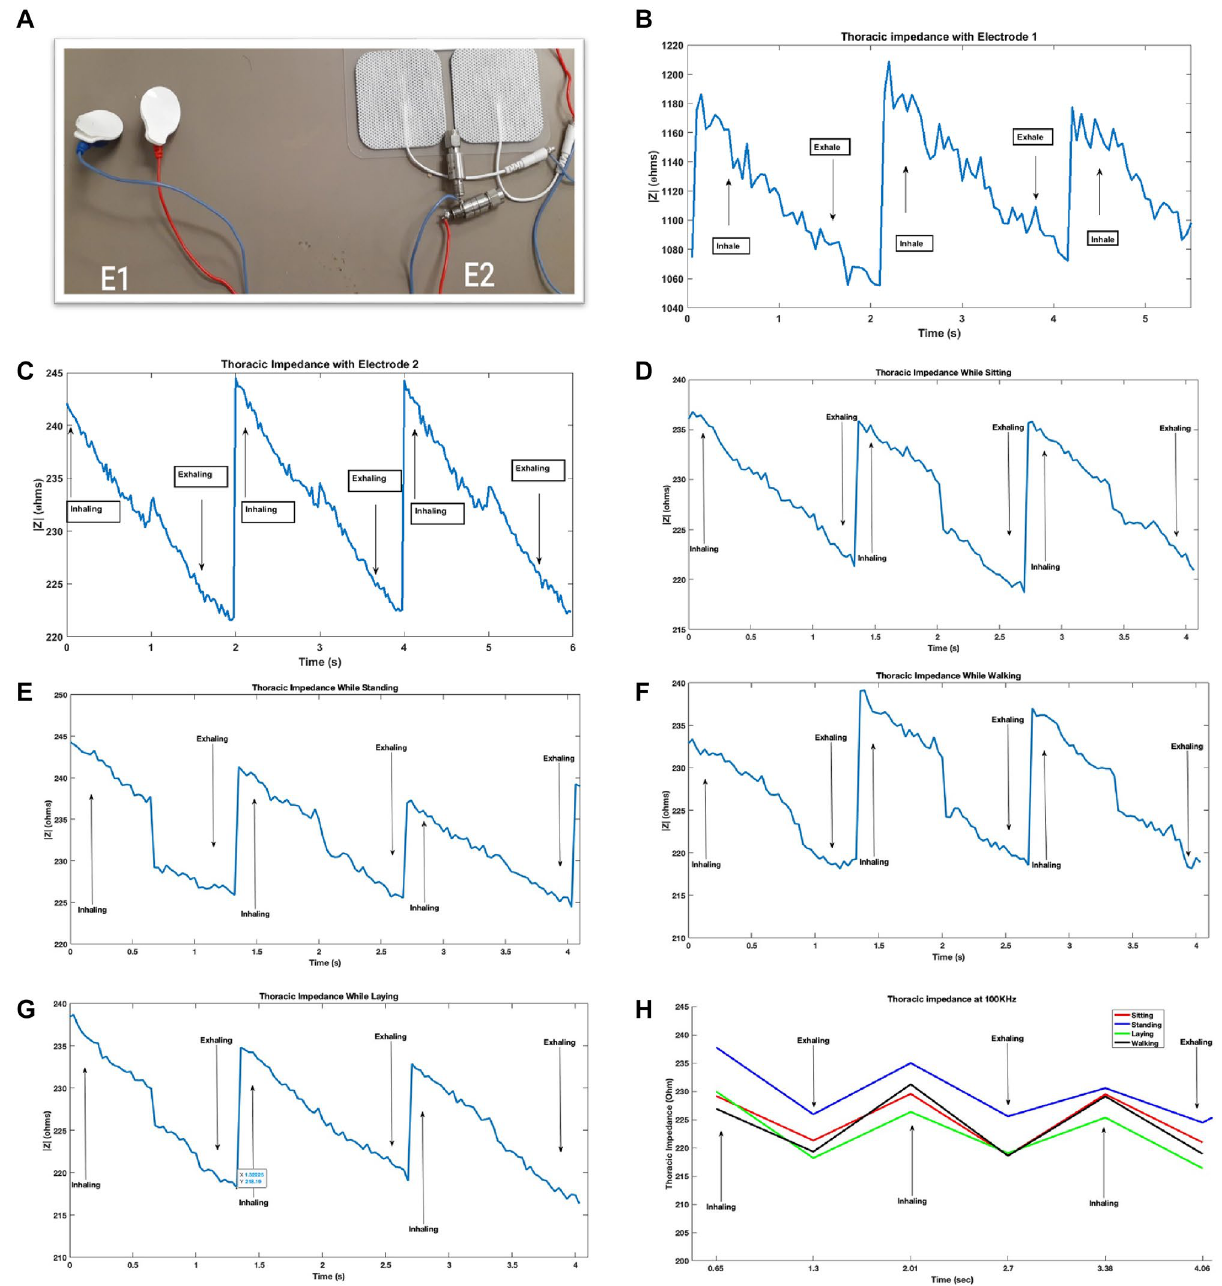
Figure 4. Thoracic impedance using PMOD IA ( A ). Two electrodes with different areas: Electrode E1 with area of 452 mm 2 and electrode E2 with area of 2580 mm 2 ( B ). Magnitude of thoracic impedance with Electrode E1 ( C ). Magnitude of thoracic impedance with electrode E2. | | Z | E1 > | Z | E2 Z| E1 >|Z| E2 ( D ). Thoracic impedance in sitting position ( E ). thoracic impedance in standing position ( F ). thoracic impedance in laying position ( G ). Thoracic impedance while walking ( H ). Thoracic impedance in different conditions at 100